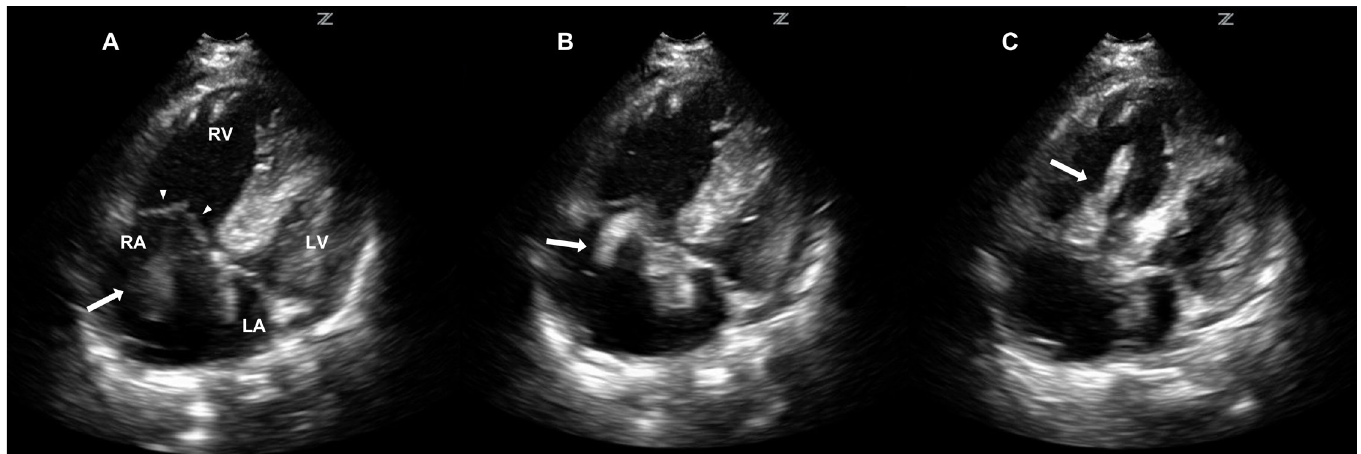
Figure 1. Bedside echocardiography in the four chamber view shows a free-floating atrial clot (arrow) as it glides between the right atrium (RA) and moves to the right ventricle (RV) during cardiac diastole and systole. A , the clot (arrow) is seen starting in the RA, B, moving through tricuspid valve (arrowheads seen in A), C, and finally seen in the RV. LA , left atrium. LV , left